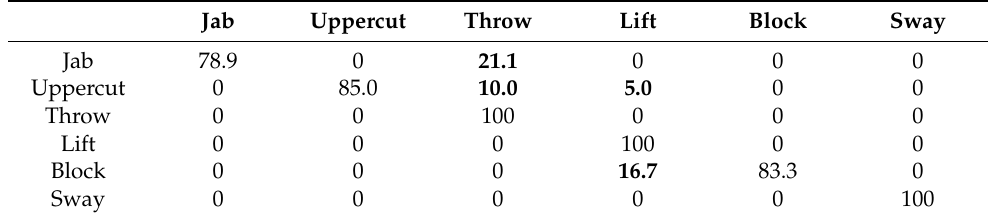
Table 3. Confusion matrix (in %) for validation set accuracy of Right Hand (60-20-20), SVM.